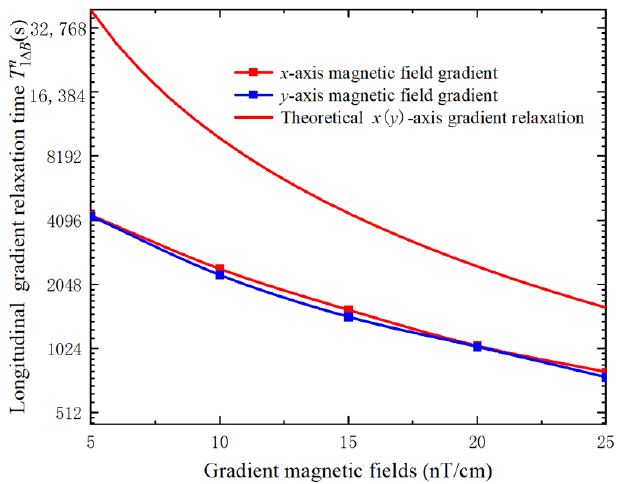
Figure 7. Measured relaxation times of the longitudinal magnetic gradient of inert atoms with an applied x - and y -axis magnetic field gradient, respectively, and curves calculated by the theoretical equations.